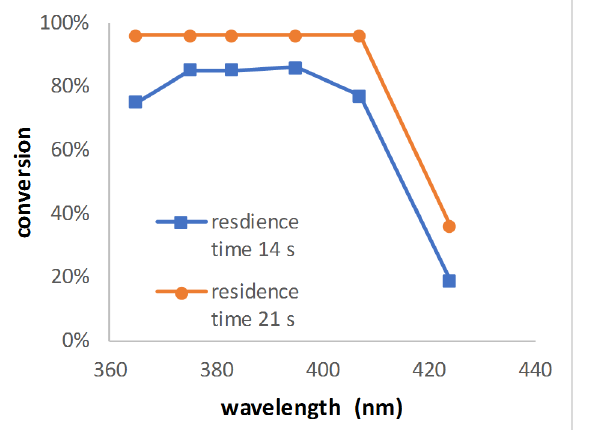
Figure 11: Conversion of citronellol as a function of the light power (0.5 mol/L of citronellol, 1.34 mmol/L rose bengal ( D ).